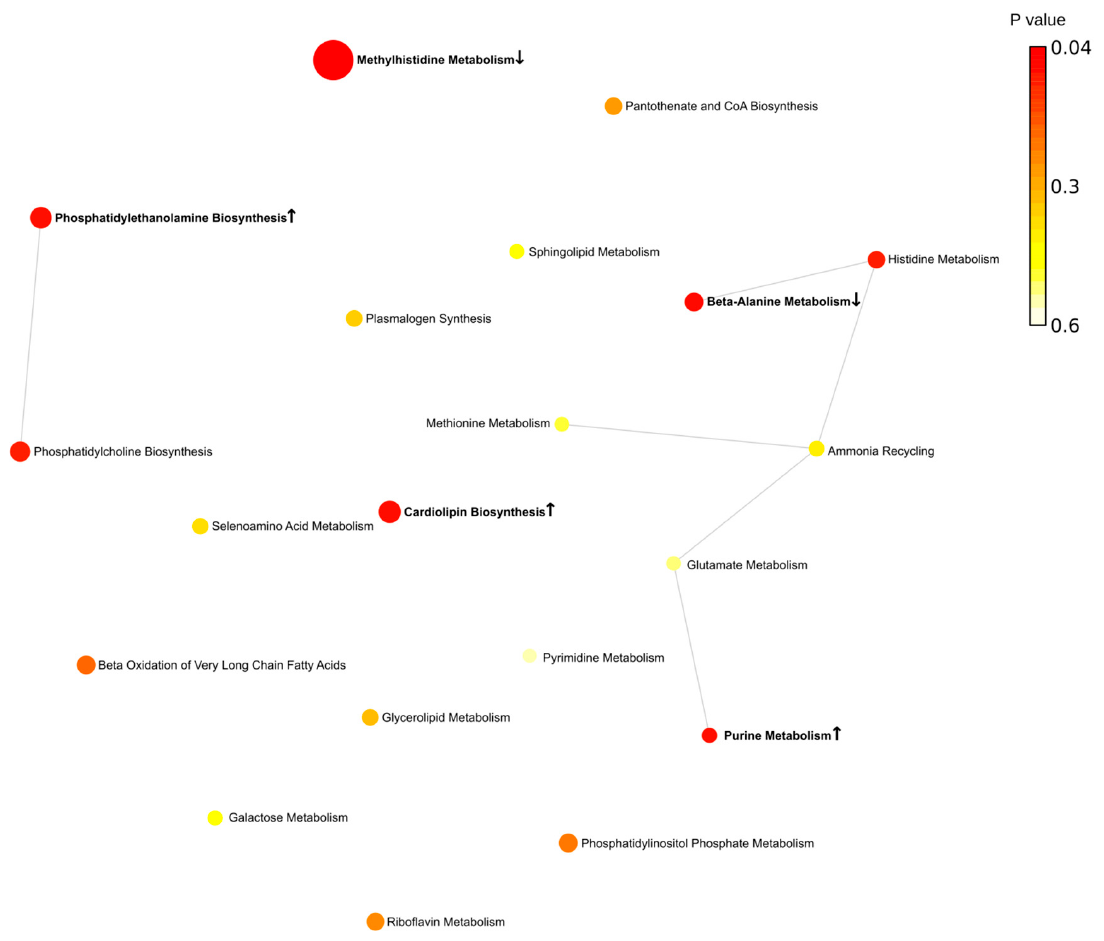
Figure 5. Metabolic pathways enriched in spring. Bold indicates significantly enriched pathways ( p < 0.05). ↑ —increased serum level of metabolites included in the metabolic pathway in MS compared to control; ↓ —decreased serum level of metabolites included in the metabolic pathway in MS compared to control. Each node represents a metabolite set with its color based on its p value and its size based on fold enrichment. Two metabolite sets are connected by an edge if the number of their shared metabolites is over 25% of the total number of their combined metabolite sets. The yellow to red color gradient and larger size of the circle indicate lower p value.